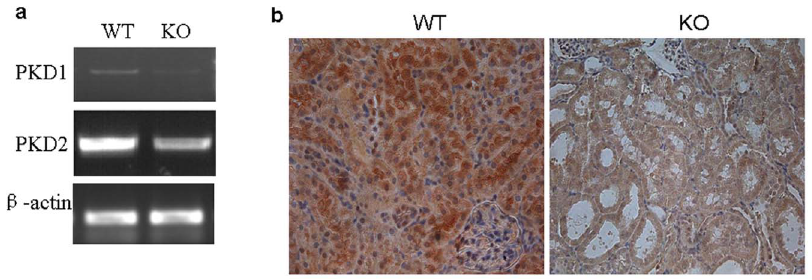
Figure 5. Gpr48 deficiency inhibited the expressions of PKD1 and PKD2. (a) The expressions of PKD1 and PKD2 were determined by RT-PCR. The mRNA levels of PKD1 and PKD2 were significantly decreased in Gpr48 KO mice compared with the WT mice. (b) Representative micrographs demonstrated the protein expression of PC1 was markedly lower in Gpr48 KO mice than in the WT adult mice. Kidneys from Gpr48 KO and WT adult mice were stained immunohistochemically for PC-1 protein. (Magnification, 400 6 ) .